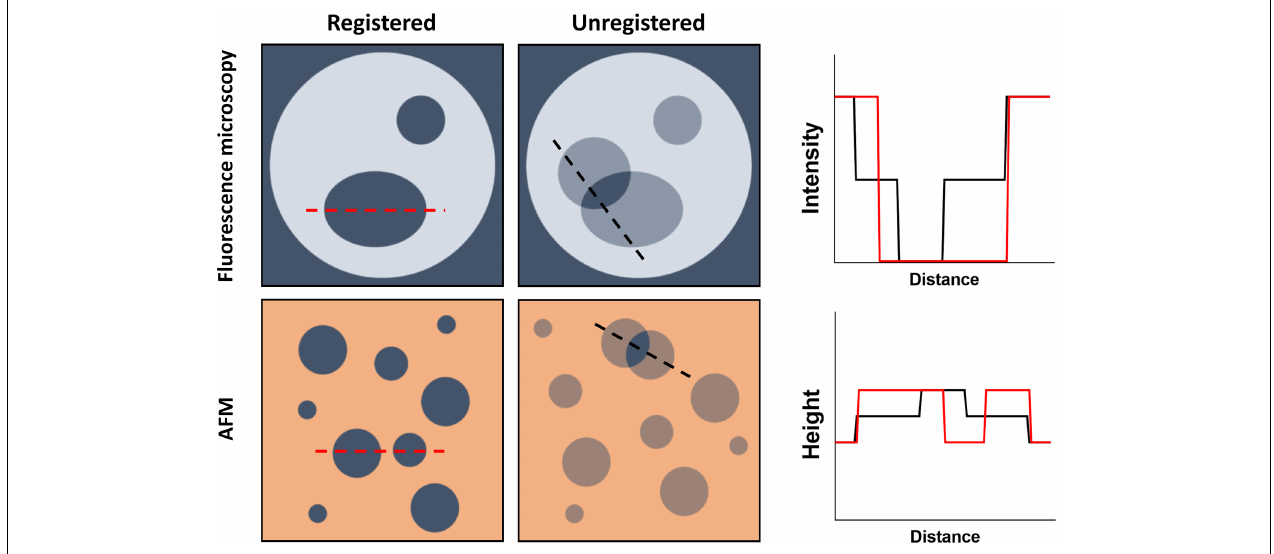
FIGURE 3 | Schematic representation of the direct visualization of lipid domains by fluorescence microscopy and AFM. (Top) Domain formation within GUVs can be assessed by fluorescence microscopy if, for example, a lipid dye with no affinity for the domains is used. For registered domains, the bulk membrane fluorescence is recorded while the domains have no intensity. Unregistered domains would present half the fluorescence intensity of the bulk membrane whenever there is no corresponding domain within the opposing leaflet. (Bottom) Using AFM, L o nanodomains, for example, can be detected by measuring the height of the bilayer, since they will be thicker than the bulk membrane. Unregistered domains would however present an intermediate membrane height resulting from the opposing bulk membrane not contributing to the thickness